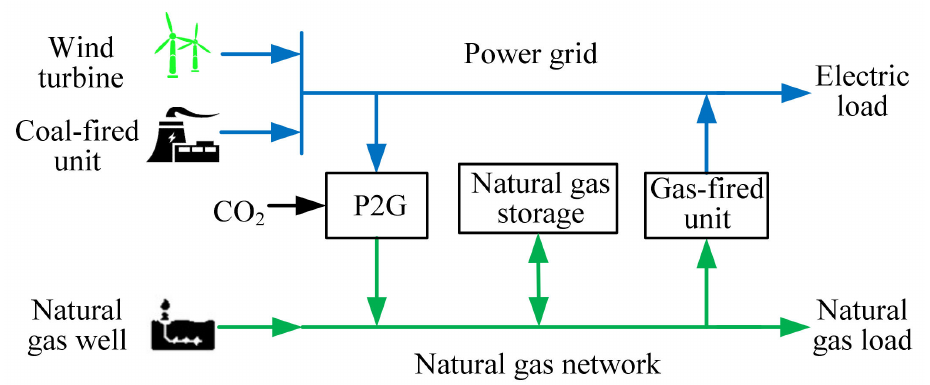
Figure 3. Diagram of the integrated power and natural gas energy system with